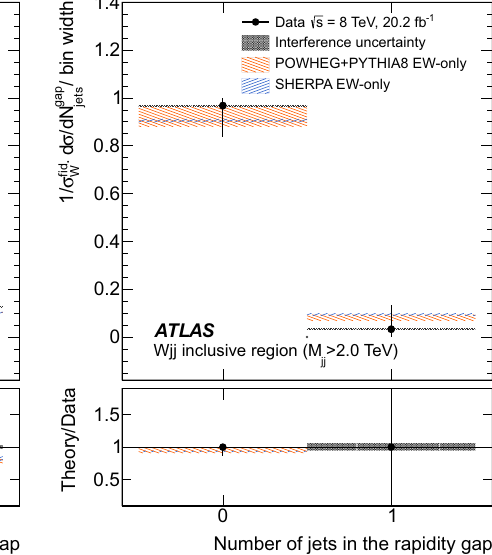
Both statistical ( inner bar ) and total ( outer bar ) measurement uncer- tainties are shown, as well as ratios of the theoretical predictions to the data (the bottom panel in each distribution)